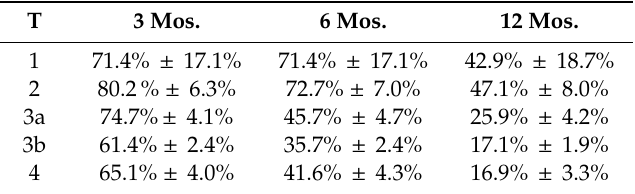
Table 3. The 3-, 6-, and 12-month overall survival (OS) rates of the ATC patients according to T category stratified by the AJCC / UICC TNM classification 8th edition.